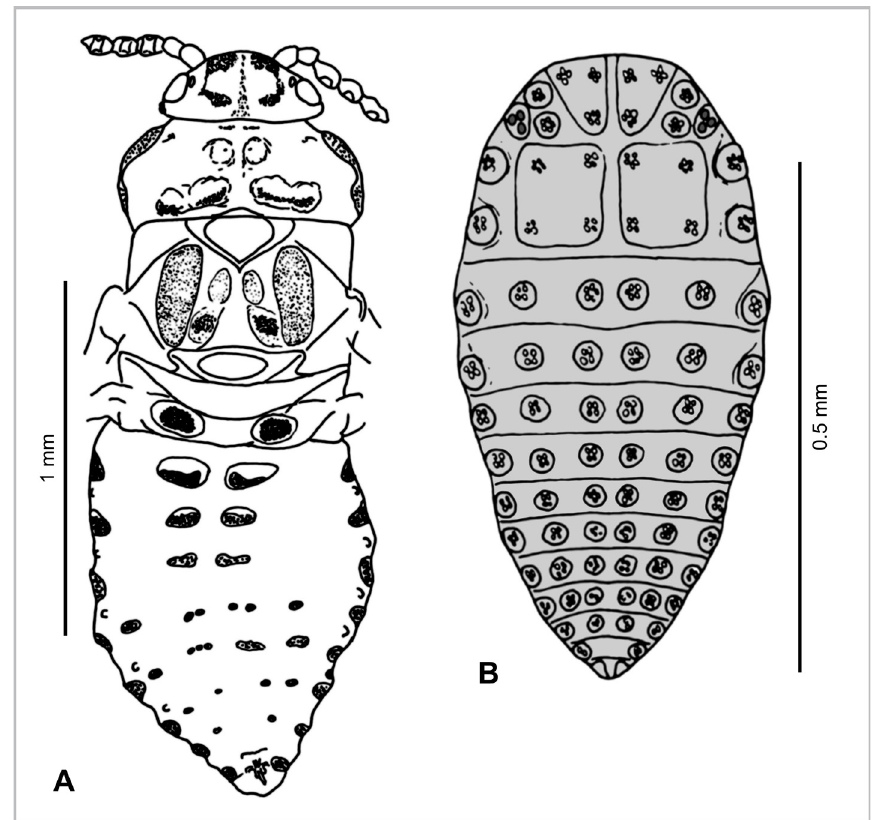
Fig. 62. Adelges (Cholodkovskya) viridanus (Cholodkovsky, 1896). A . Alata (after Carter 1971, redrawn from Heie 2004). B . Neosistens (after Inouye